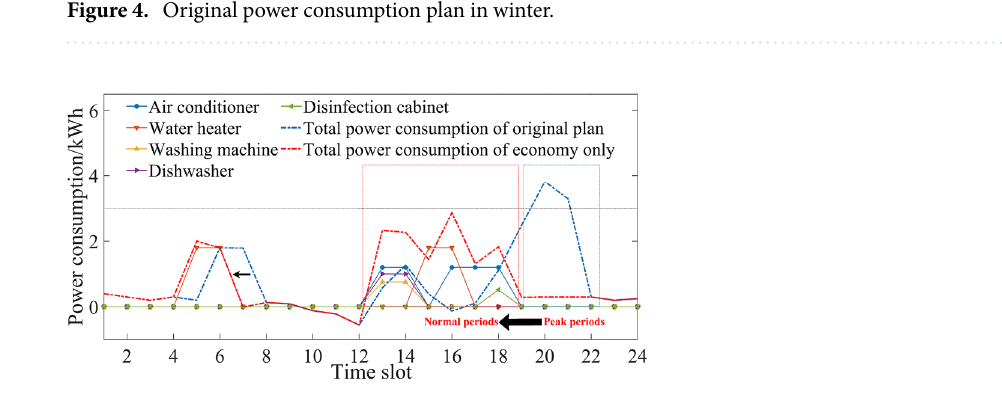
Figure 5. Power consumption plan aiming to minimize costs in summer.